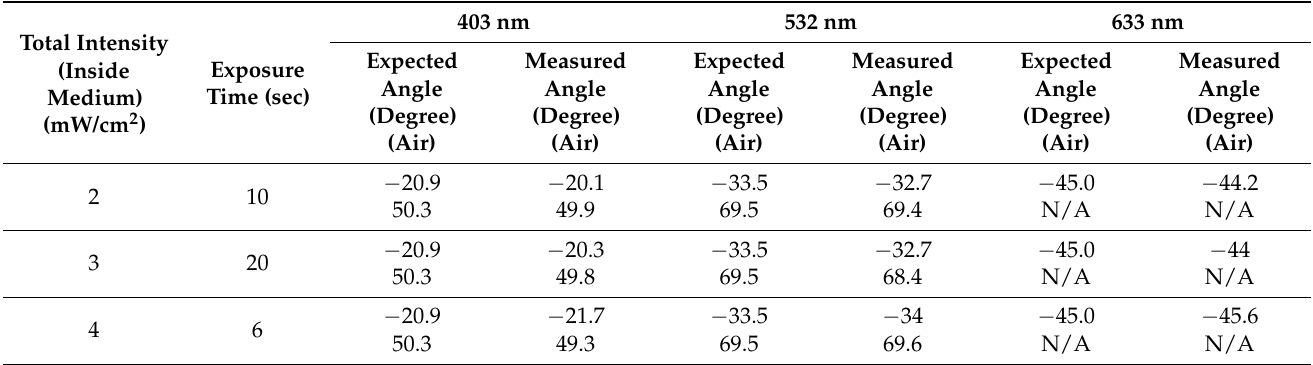
Table 2. The model-predicted angles (in air) and measured angles (in air) for all three different